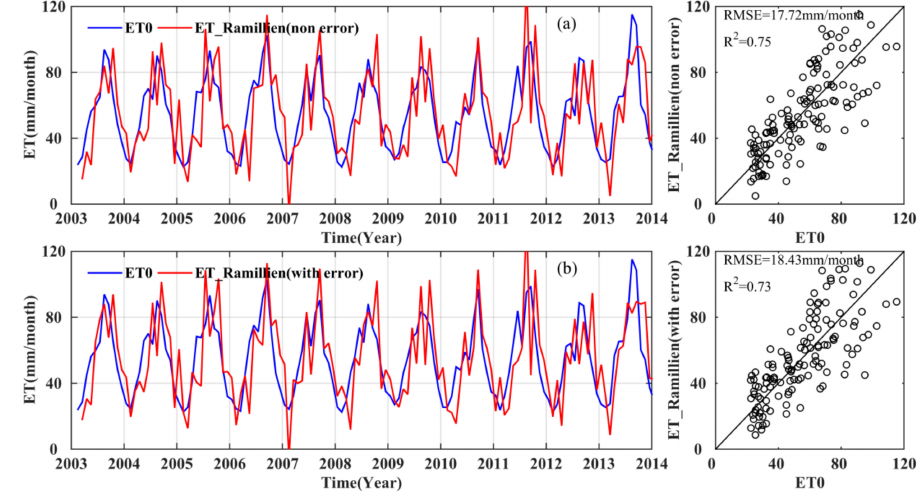
Figure 2. Monthly evapotranspiration (ET) estimated from simulated Gravity Recovery and Climate Experiment (GRACE) terrestrial water storage (TWS) and daily P and R observations ( a ) without error and ( b ) with error, using the method introduced by Ramillien et al.